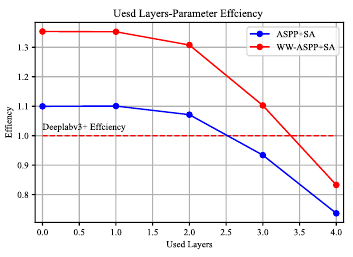
Figure 12. Efficiency Comparison of ASPP&WW-ASPP